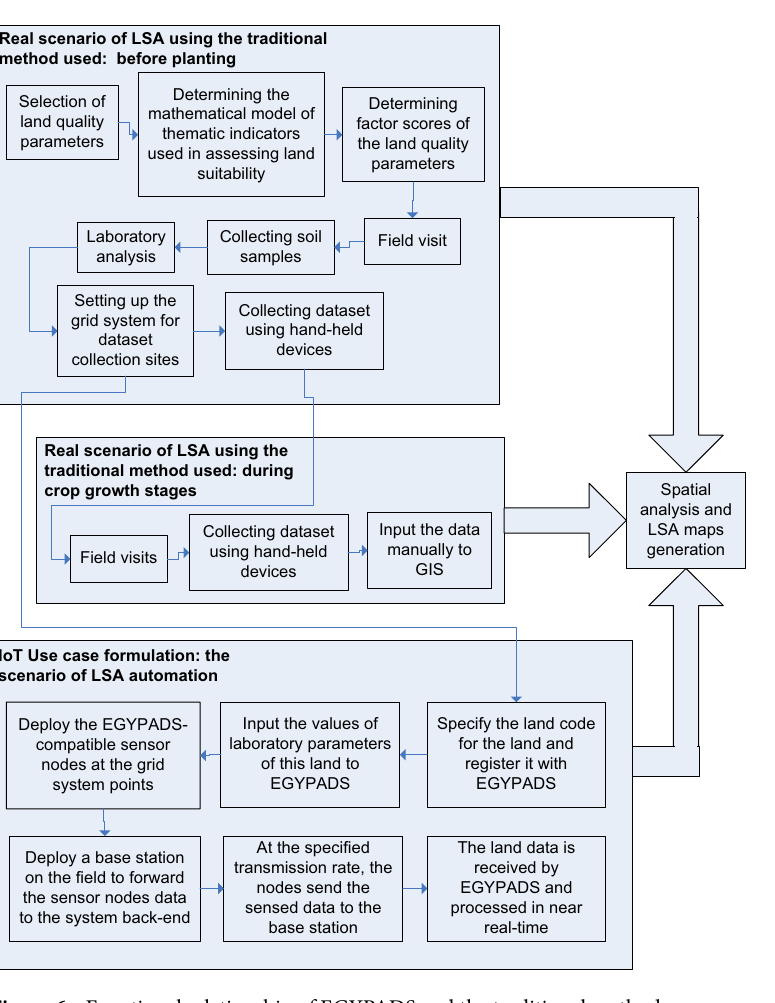
Figure 6. Functional relationship of EGYPADS and the traditional method.